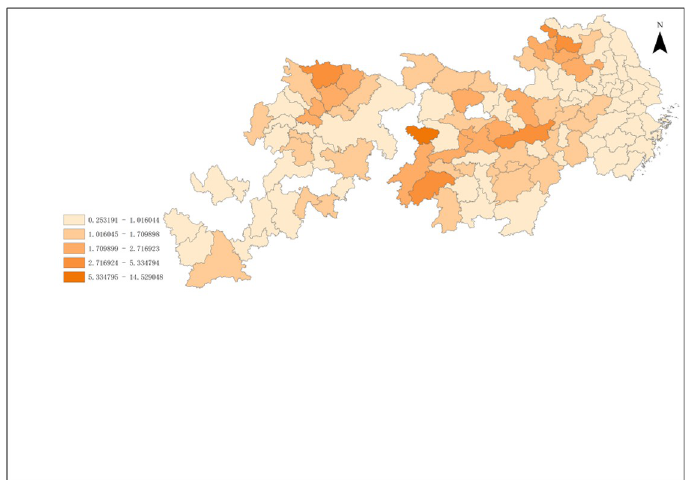
Fig 9. Industrial technical efficiency of cities in Yangtze River Economic